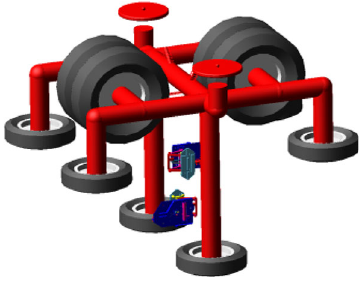
Fig. 5 The bogie model equipped with pantograph